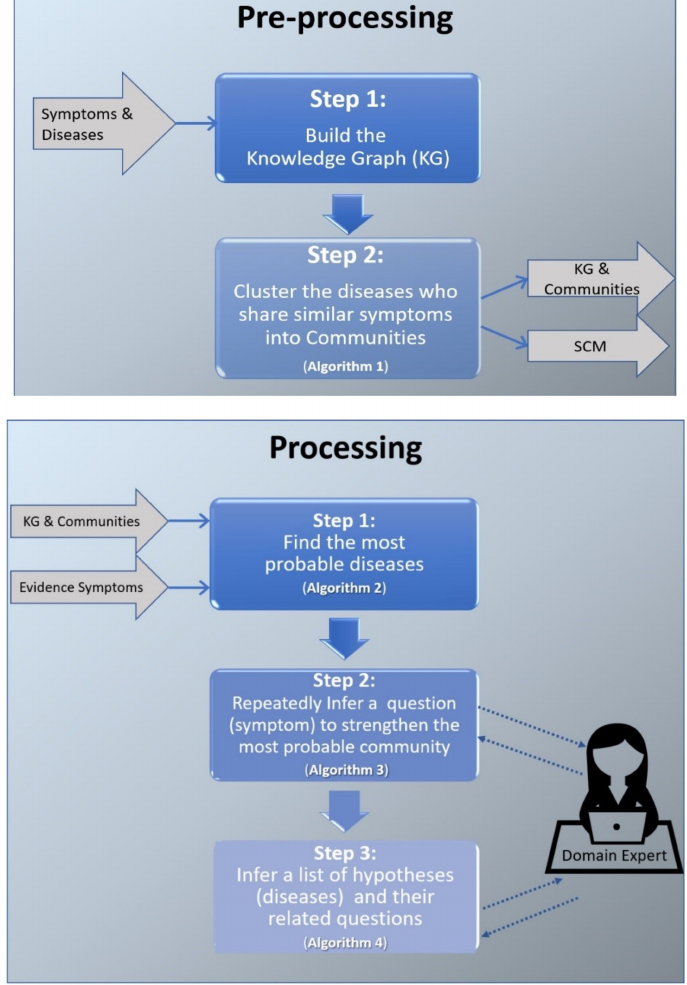
Figure 1. A high-level view of the framework. On the top, we demonstrate the pre-processing part, on the bottom the processing part.